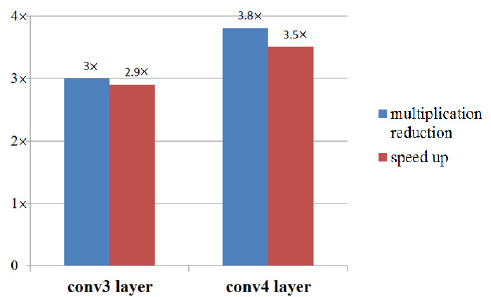
Figure 12. Speed up of fast algorithm in conv3 and conv4